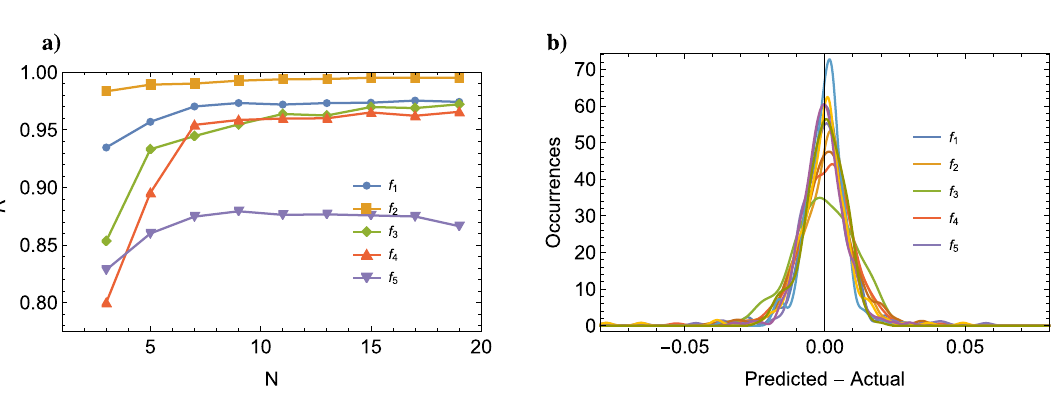
Figure 3. ( a ) Individual values of the R 2 (predicted vs. actual) of the first five eigenfrequencies f 1, ... ,5 of the violin top plates. As we can see, from N = 15 the network begins overfitting f 5 in the training set, as the error in the test set start growing. Notice that, with fewer than 7 neurons, the network is unable to offer a correct prediction. ( b ) Histograms of the difference between the eigenfrequency predicted by the neural network with N = 7; and the FEM result for the first five